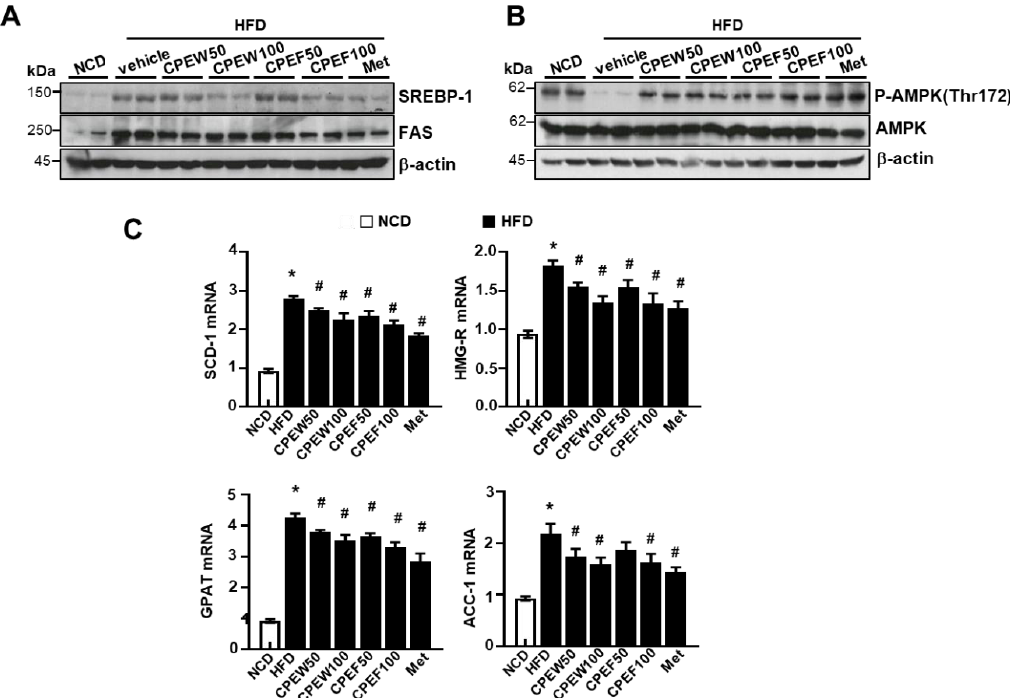
Figure 5. Citrus peel extract inhibits HFD-induced lipid synthesis. Rats were placed on either an NCD or 60% HFD for eight weeks and were supplemented with ultra-pure water, metformin (100 mg/kg), or one of the indicated concentrations of citrus peel (50 and 100 mg/kg). ( A ) Immunoblotting was performed using antibodies against anti-SREBP-1, FAS, ( B ) p-AMPK and AMPK and β-actin. ( C ).